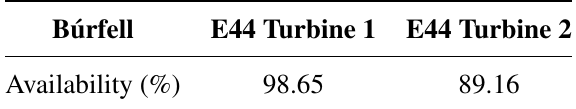
Table 3. Measured availability for both E44 900-kW wind turbines at